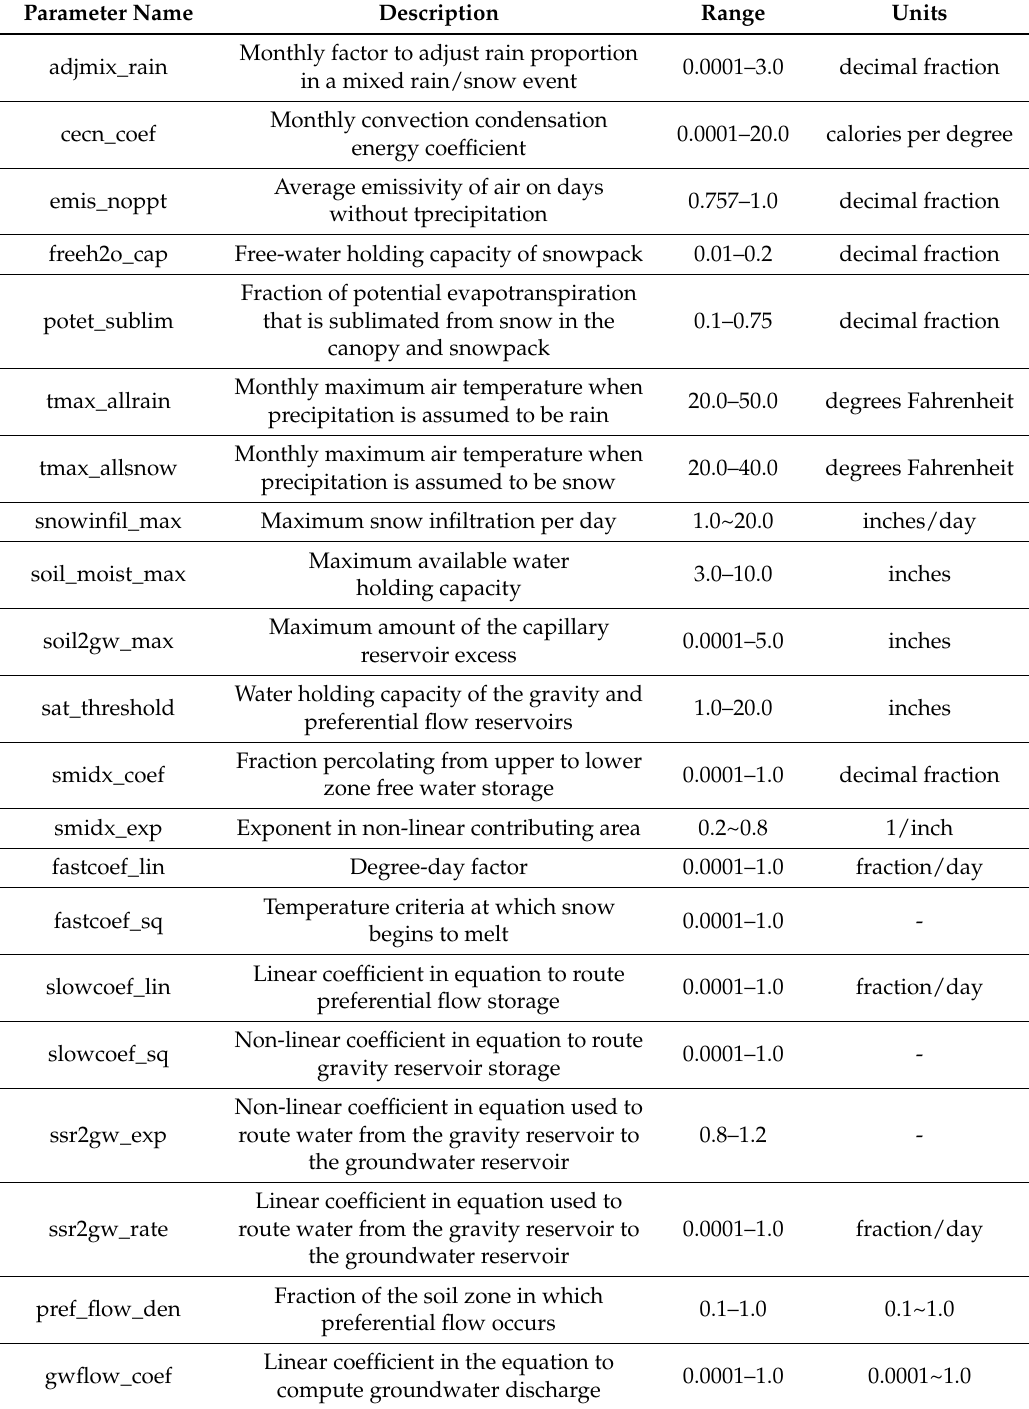
Table 1. Calibrated PRMS parameters used in the present study, including physical